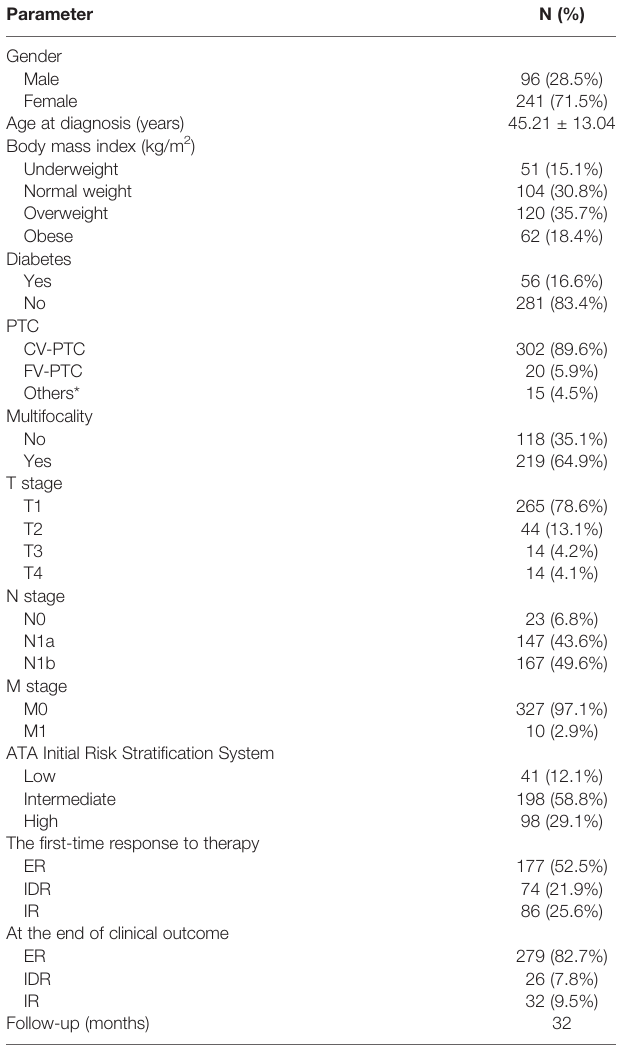
TABLE 1 | Baseline characteristics of papillary thyroid cancer (n =